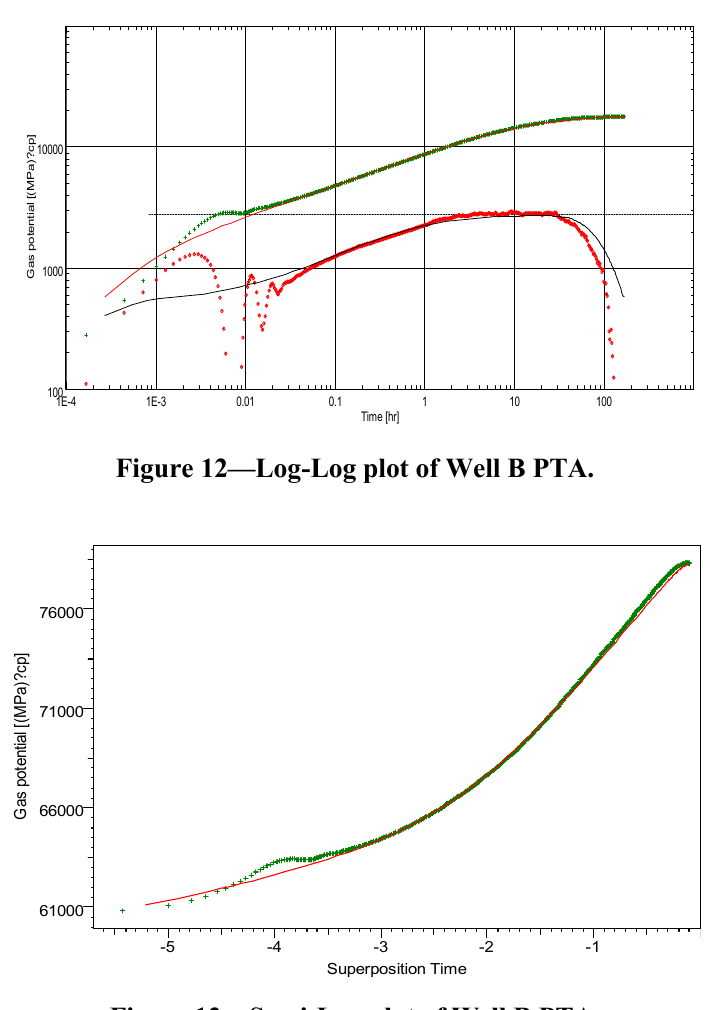
Semi-Log plot: m(p) [(MPa)?cp] vs Superposition Time Figure 13—Semi-Log plot of Well B